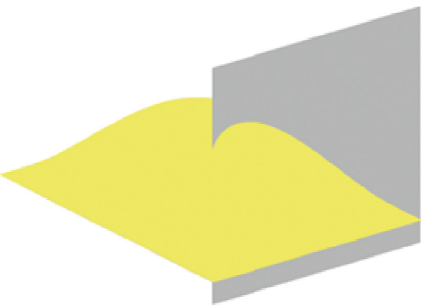
Figure 20: Intersection of both surfaces.